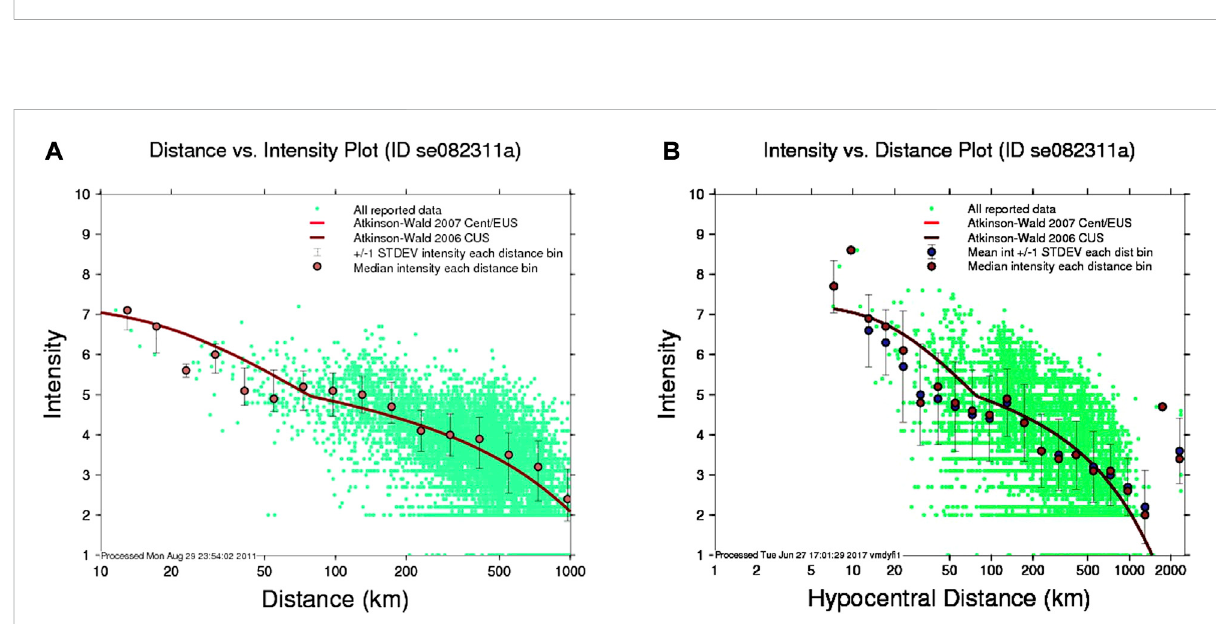
FIGURE 4 Comparison of time-stamped, system-generated Did You Feel It? Intensities versus hypocentral distance for the 2011 Mineral, Virginia, earthquake, downloaded on (A) 29 August 2011 and (B) 27 June 2017. Different plotting conventions were used to generate these plots, but both panels include the same reference intensity prediction equation (IPE; red line). Note that average intensities in (A) are highly consistent with the IPE for distances between 50 and ~300 km, whereas average intensities in (B) systematically fall below the